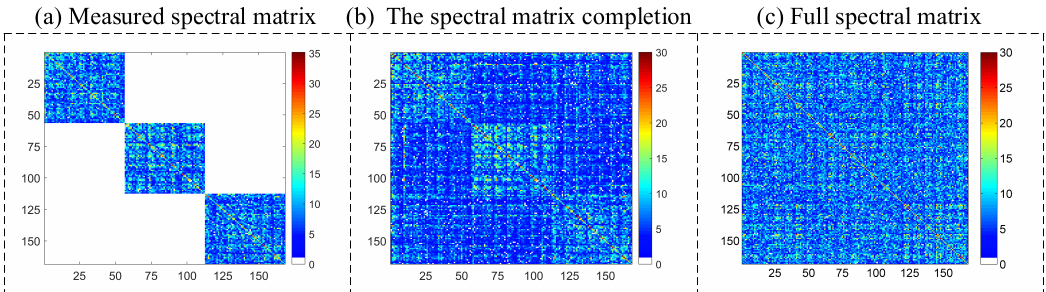
Figure 11. Comparison of the spectral matrix between the synchronous and non-synchronous measurements. ( a ) Measured cross-spectral matrix. ( b ) The spectral matrix completion from the non-synchronous measurements. ( c ) Full spectral matrix from the synchronous measurements.